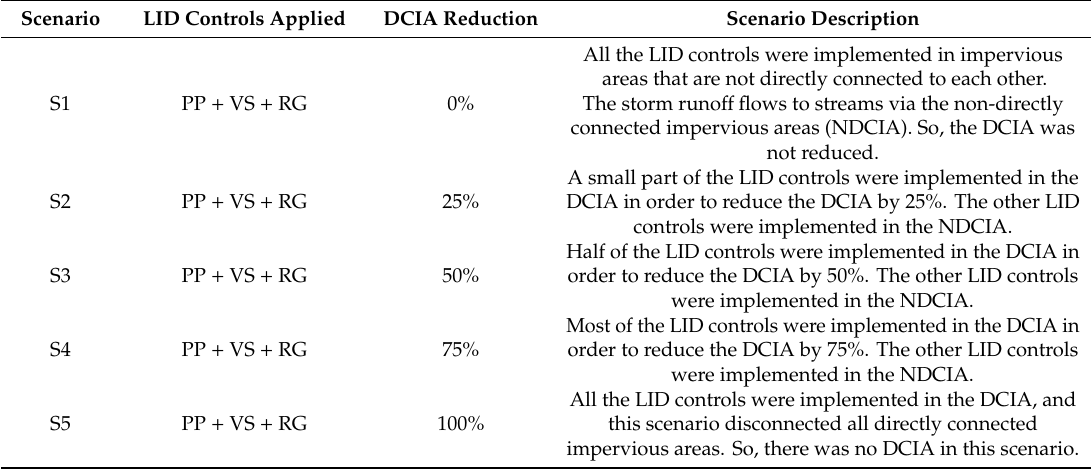
Figure 8. Reducing directly connected impervious area by implementing LID controls. Table 4. Descriptions of five design scenarios.